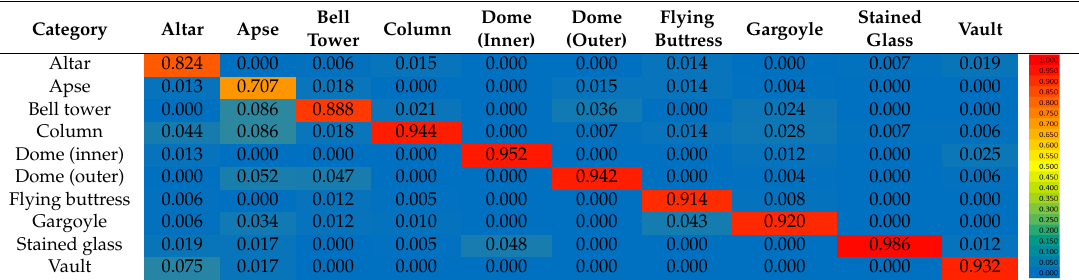
The corresponding values of Recall (Sensitivity), Precision, Specificity, Balanced accuracy and F1 score have also been calculated (Table 10). Table 10. Different metrics of the results obtained in each class using a ResNet network (full-training) and the test dataset.